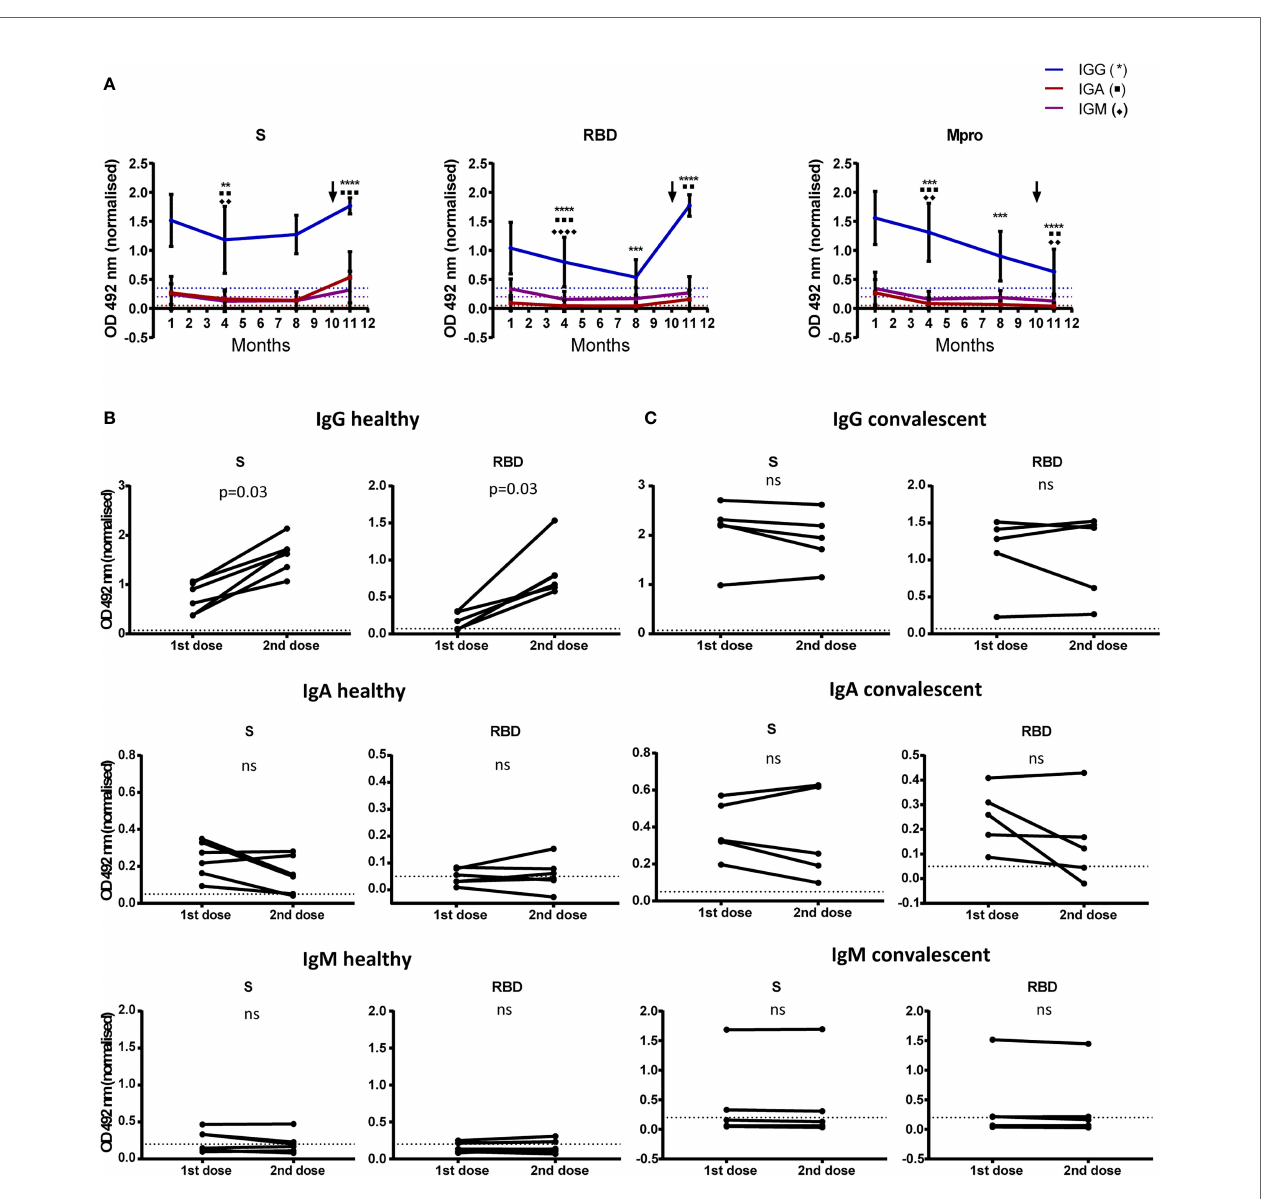
FIGURE 4 | Antibody levels to SARS-CoV-2 before and after vaccination. (A) 11 month-follow up of 18 CD. The mean and SD of optical density at 492 nm are shown for IgG, IgA and IgM. Dilutions of 1/200 for IgG and 1/50 for IgA and IgM were used. Antibody detection at month 1 corresponds to samples collected 3 months after disease onset. First dose of the vaccine was administered at month 9 (month 11 after disease onset; arrow). Determination of antibodies at month 11 corresponds to second vaccine dose administration. Optical density was normalized using the signal obtained with a pool of positive sera.**p < 0.01; ***p < 0.001; ****p < 0.0001. (B, C) Comparison of SARS-CoV-2 antibody levels determined after each vaccine dose. Paired graphs show anti-S and RBD IgG, IgA and IgM in sera of 5 HD (B) and 5 CD (C) Sera dilutions of 1/3200 for IgG and 1/50 for IgA and IgM were used. Optical density at 492 nm was normalized using the signal obtained with a pool of positive sera. Statistical signi fi cance was analyzed by Wilcoxon test. Positivity threshold was calculated as 3 SD above mean in healthy donors in all cases (dotted lines). ns, non signi fi